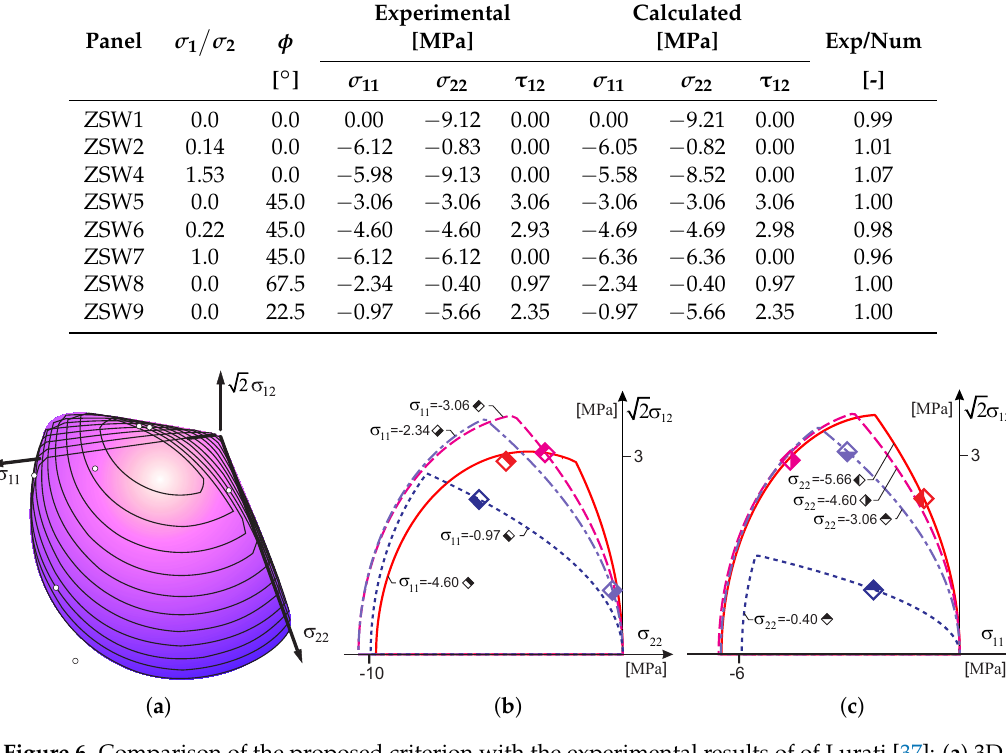
Table 2. Comparison of the proposed criterion with the experimental results of [37].